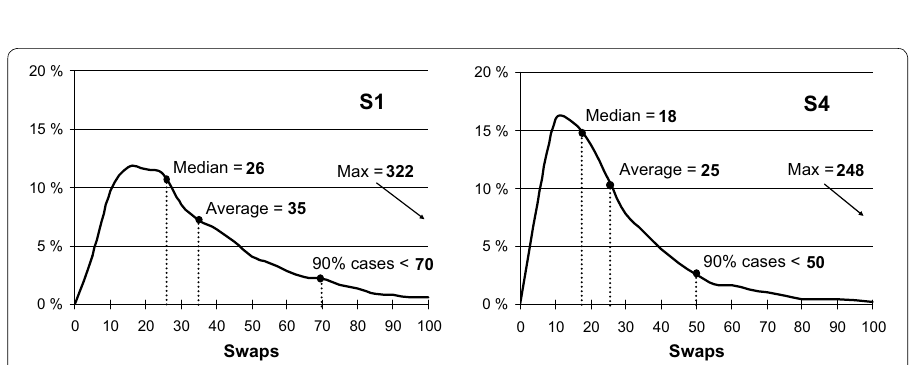
Fig. 13 Distribution of the number of trial swaps needed in reality for S 1 and S 4 (10,000